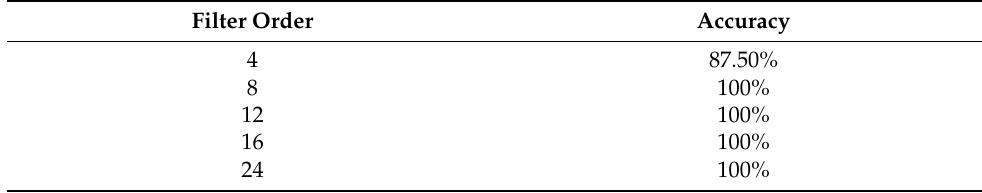
Table 1. Test results of spike detection accuracy with different FIR filter orders.